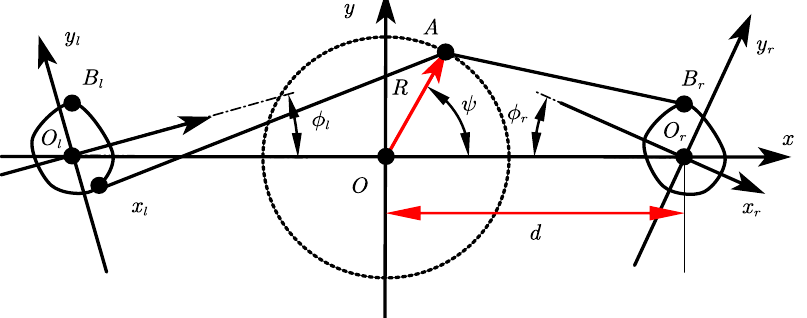
Figure 2. The model of the string-based mechanism. 𝑥𝑂𝑦, 𝑥 𝑟 𝑂 𝑟 𝑦 𝑟 , 𝑥 𝑙 𝑂 𝑙 𝑦 𝑙 RCS is fixed to the crank, right, and left pulley.